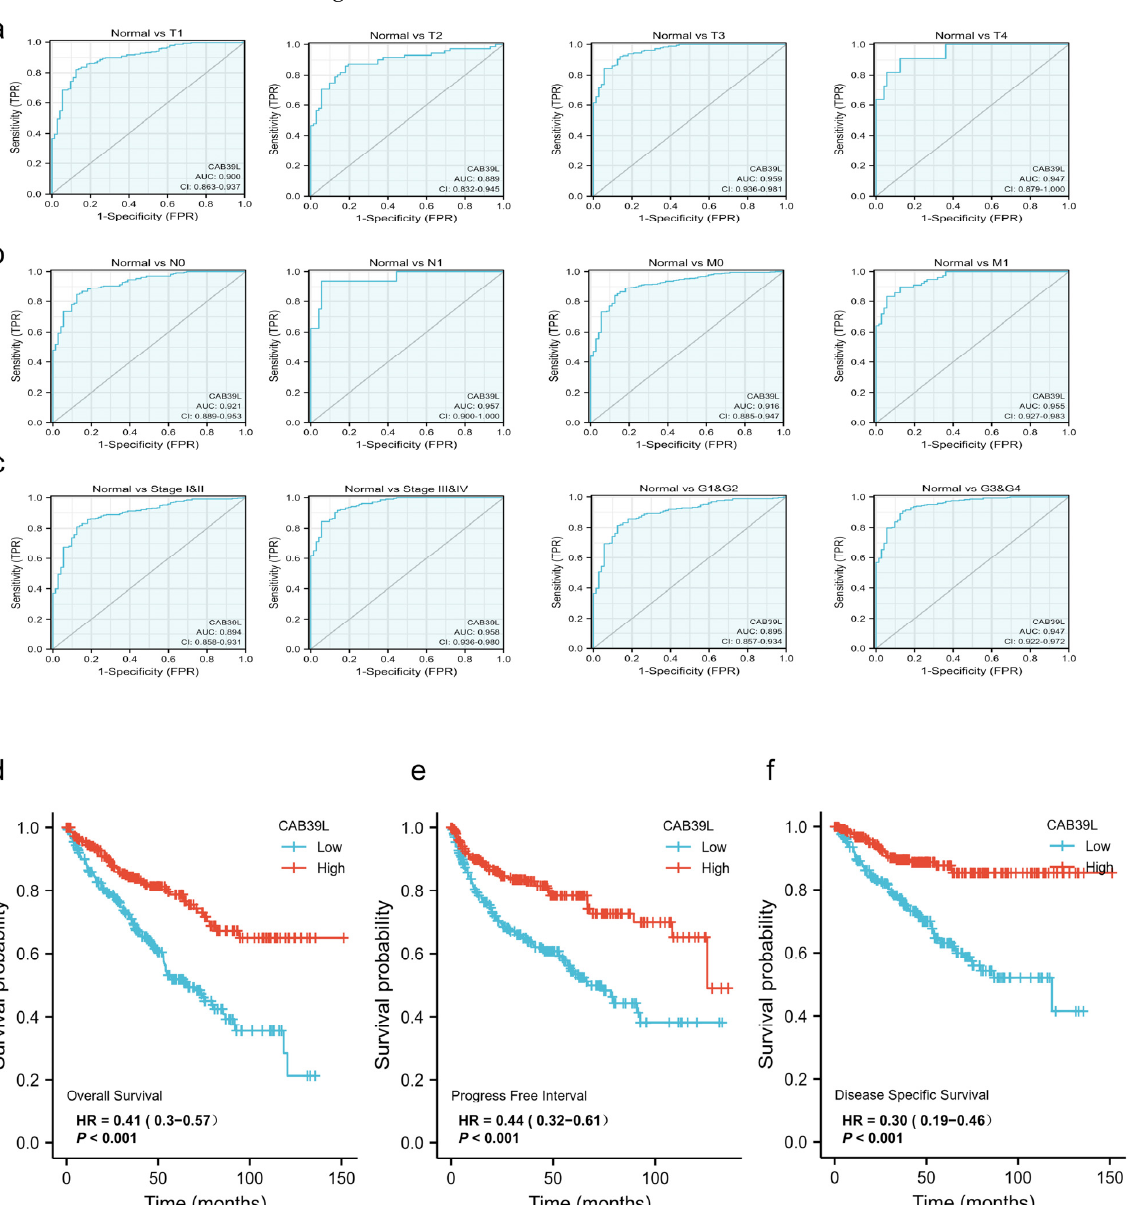
Figure 4. Diagnostic and prognostic capacity of CAB39L in KIRC. ( a ) Diagnostic capacity of CAB39L expression in KIRC patients at T stage by ROC curves. ( b ) Diagnostic capacity of CAB39L expression in KIRC patients at M and N stages by ROC curves. ( c ) Diagnostic capacity of CAB39L expression in KIRC patients at different histologic grade and pathologic stage by ROC curves. ( d ) Association between CAB39L expression and OS (TCGA). ( e ) Association between CAB39L expression and PFS (TCGA). ( f ) Association between CAB39L expression and DSS (TCGA). Progression-free survival (PFS), disease-speci fi c survival (DSS), overall survival (OS).